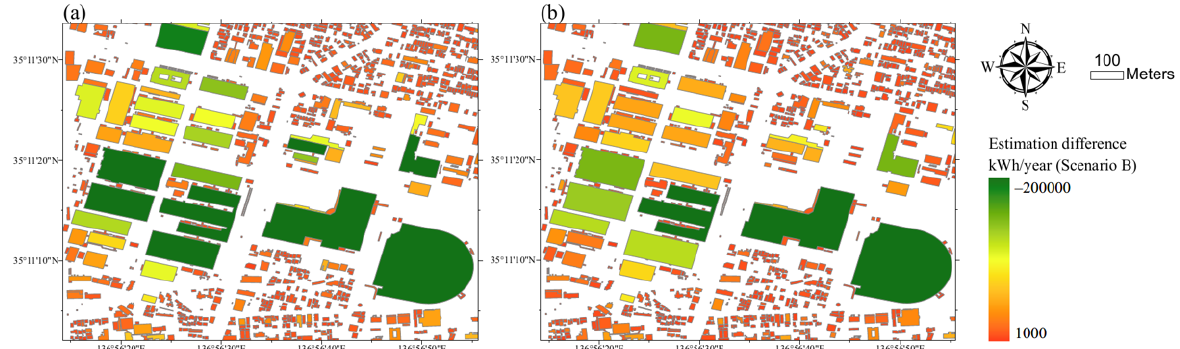
Figure 7. The differences in the estimation of solar power potential of each roof ( a ) between Method 1 and Method 3 ( b ) between Method 2 and Method 3 under Scenario B (kWh/year). The number and cumulative proportion of buildings in terms of the solar power po- tential of each roof (kWh/year) in the study area estimated by the three methods under Scenario B are shown in Figure 8. The total number of buildings was 475,764, including buildings without solar power potential (height lower than 1.5 m or roof area less than 10 m 2 ). The standard potential of annual solar power generation of more than 90% of build- ings at the current technology level (Scenario B) was smaller than 30,000 kWh/year in the study area estimated by the three methods. For Method 2, the annual solar power poten- tial of 31% of the total buildings was under 1000 kWh/year. This was because 126,823 buildings lacked solar power potential due to the fact that their height was less than the 1.5 m set by the DCM based on the AW3D data. Excluding this factor, the majority (22.5%, estimated by Method 2, to 27.7%, estimated by Method 1) of total buildings in the study area had an annual solar power potential between 5000 and 10,000 kWh/year. Method 1 included the analysis of roof structure, while Method 2 and Method 3 treated all roofs as flat, and parameter H for a flat roof (3.74) was larger than most of the other angles and aspects in Table 2; therefore, the distribution of the number of buildings shifted left for Method 1 in Figure 8. In terms of buildings with solar power potential larger than 10,000 kWh/year under Scenario B, the number of buildings in Methods 2 and 3 was higher than that in Method 1, because the buildings with large roof areas included some factories whose roofs were not flat. In this case, the solar power potential estimated by Methods 2 and 3 would be greater than that estimated by Method 1.